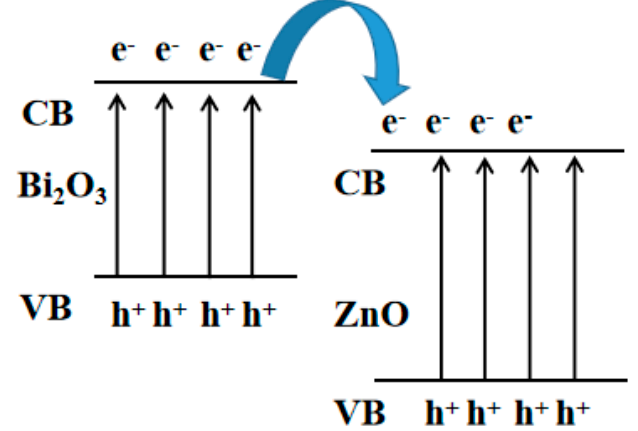
Figure 9. ZnO/Bi 2 O 3 composite band diagram.